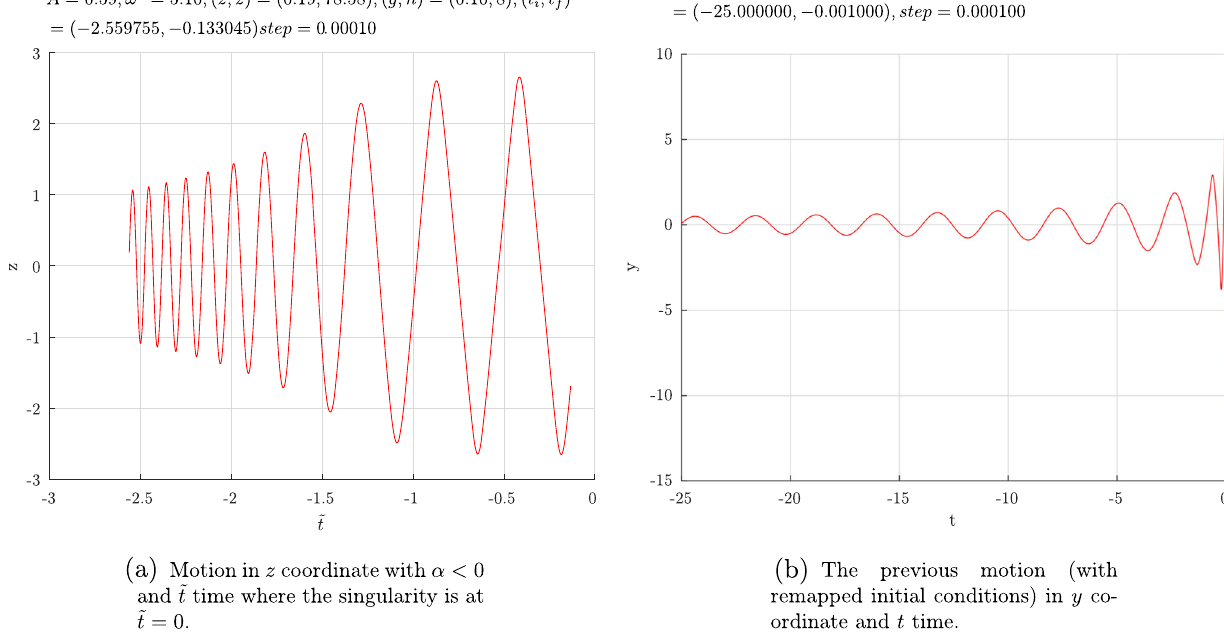
Fig. 5 Classical motion with α < 0 with a too short integration range to show the expected behavior